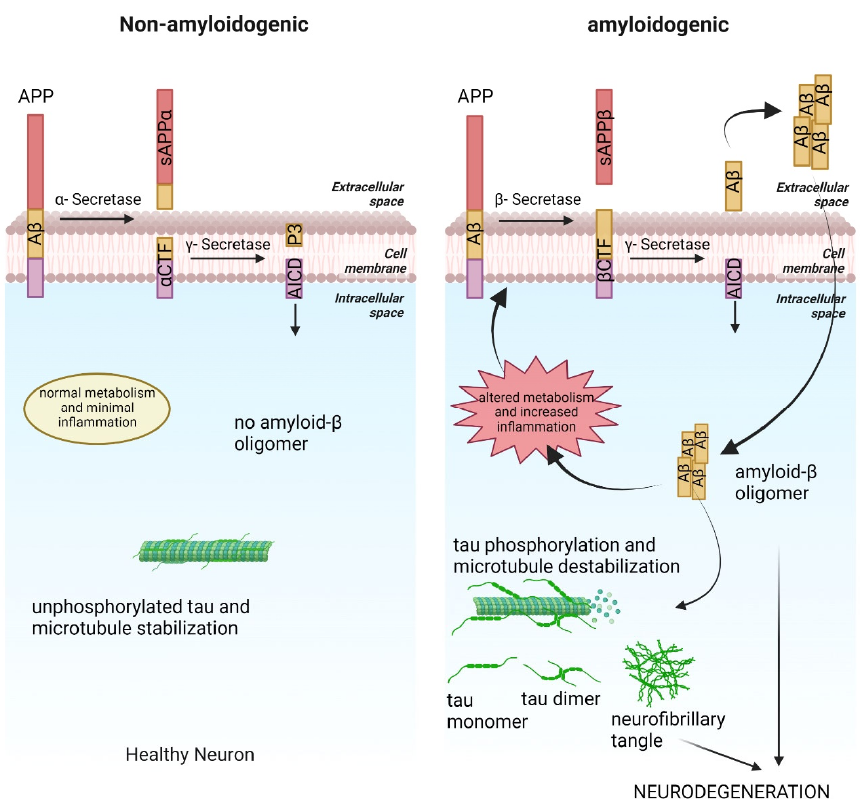
Figure 1. Differences between non ‐ amyloidogenic and amyloidogenic pathways in Alzheimer’s disease (AD). Non-amyloidogenic cells have normal cellular metabolism, a low level of inflammation, and stable microtubules. Amyloidogenic cells show metabolic alteration, increased inflammation, amyloid aggregates, destabilized microtubules, and tau ‐ aggregates.